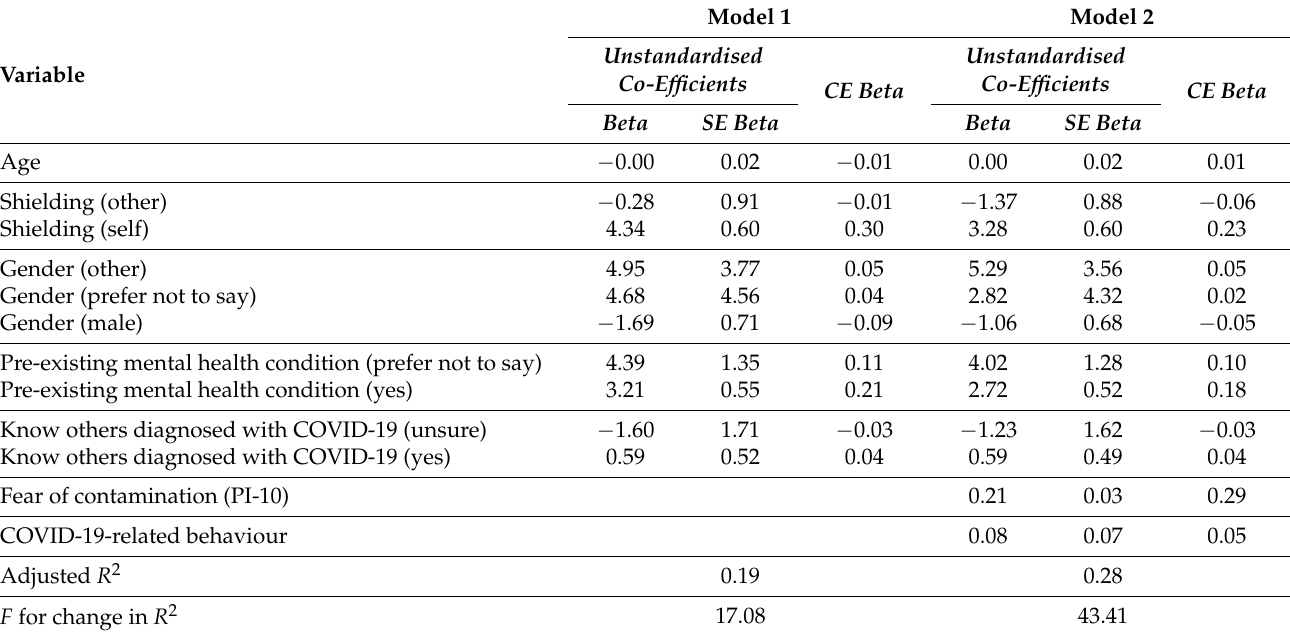
Table 7. Summary of multiple regression for predicting health